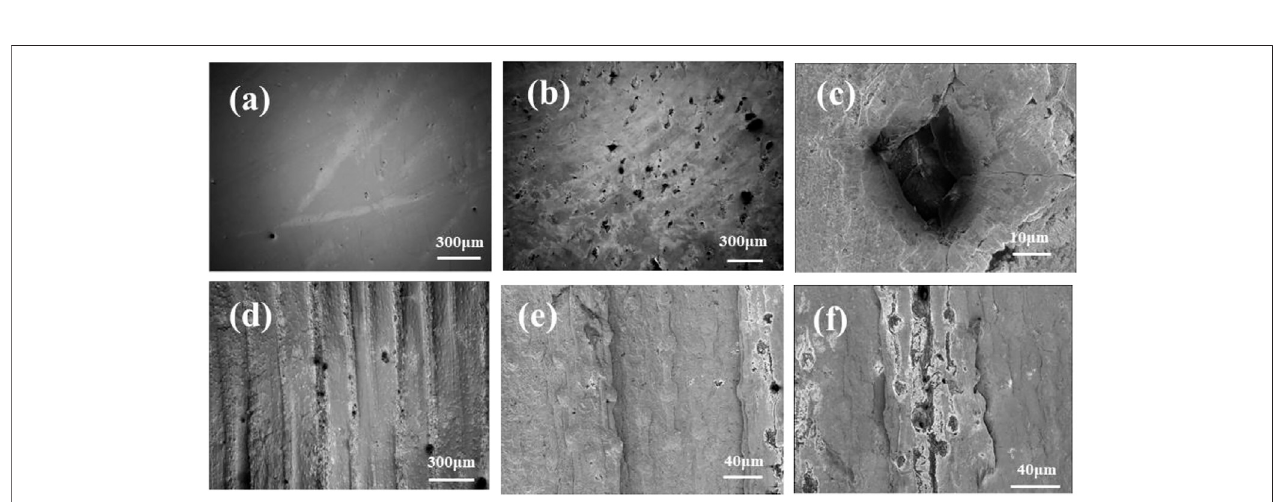
FIGURE 4 | The surface SEM images of IPMC fi lms with different microstructures. (A) Surface of sample NN. (B-C) Surface structure of sample RR. (D-F) The surface biological structure in sample LN.